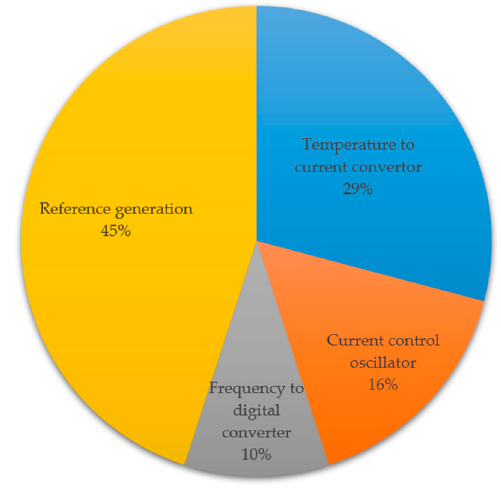
Figure 7. Power consumption breakdown of the presented temperature sensor chip (simulated).